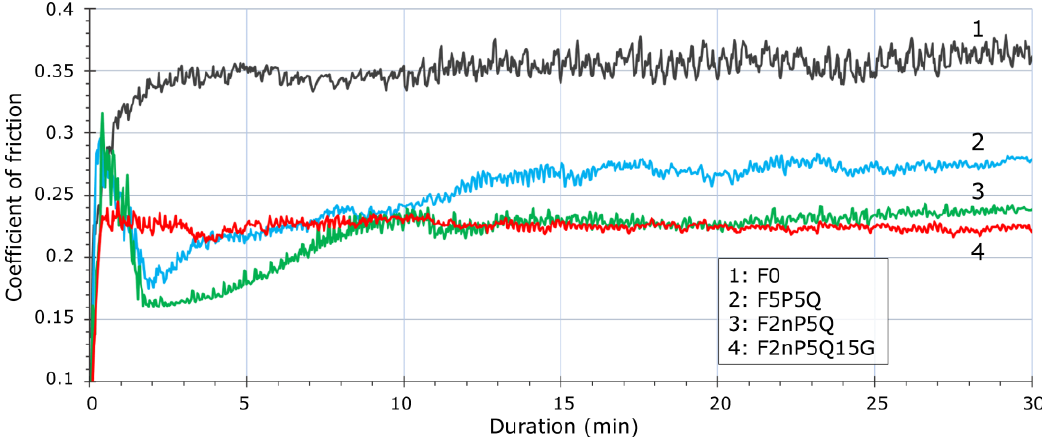
Figure 10. Time dependence of friction coefficient for unfilled FEP and FEP-based composites.